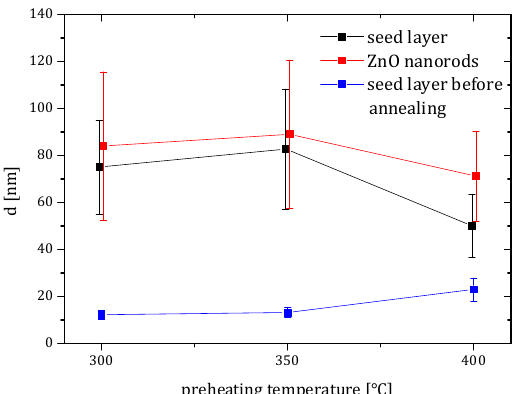
Figure 2. Size analysis of the seed layer crystallites after preheating at different temperatures (blue full squares) and after complete heat treatment including different preheating temperatures and annealing in the air at 600 °C (black void squares). Furthermore, the red full squares represent the diameters of the nanorods grown on the seed layers preheated at different temperatures and annealed in the air at 600 °C.